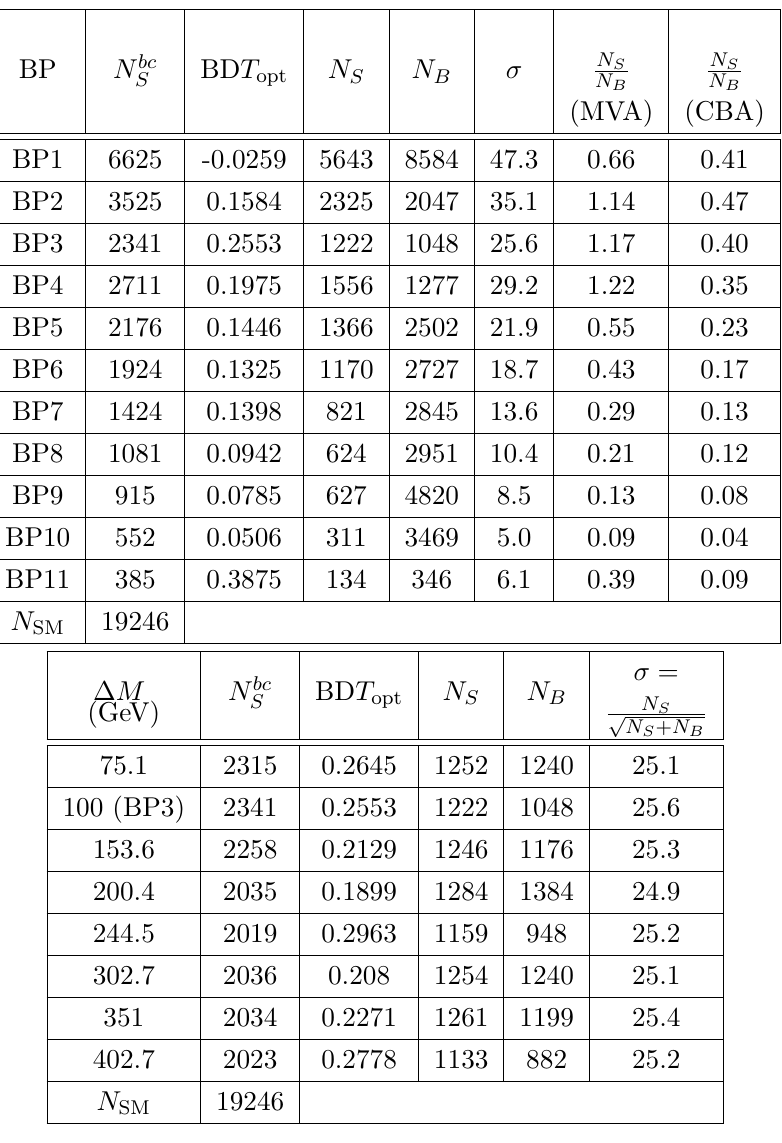
Table 7. The upper table demonstrates the effectiveness of the current search in terms of statistical significance ( σ ) for different benchmark points conceived for this study. The lower table illustrates the variation of this potential for one benchmark point, changing the mass of the heavy scalar, S 2 , and shows that this mass does not have much impact in exploring the parameter space. N bc and N are the total number of events for different signal benchmark points and the combined SM background before applying any cut on BDT output (as shown in table 6). After using an optimal selection on the BDT response (BD T ) surviving number of signal and background events are given opt by N and N , respectively for 14 TeV LHC for an integrated luminosity 139 fb − 1 . Corresponding S B statistical significance and the signal-to-background ratio are also presented for ready reference. To better compare the sensitivities between the different analysis methods, we add the N S CBA from table 5 in the last column of the upper